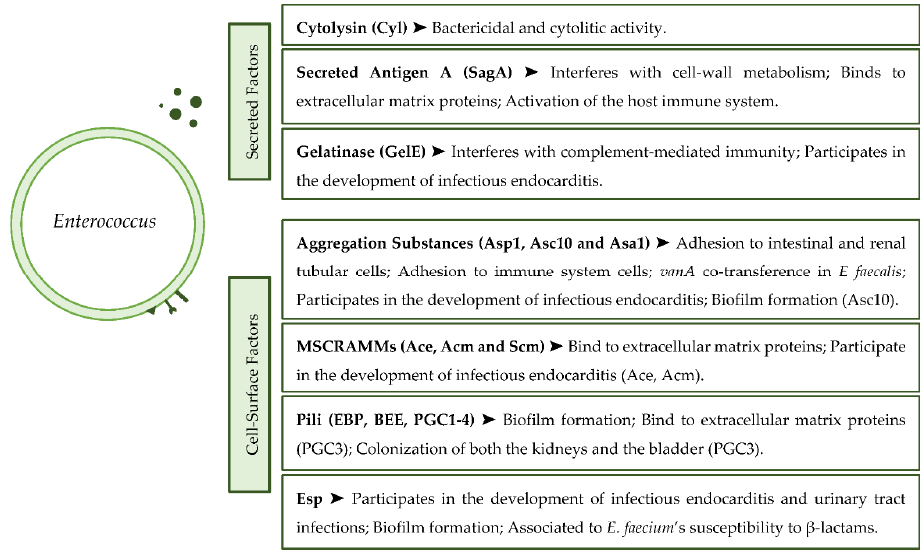
Figure 1. Summary diagram of the most relevant virulence factors present in enterococci.